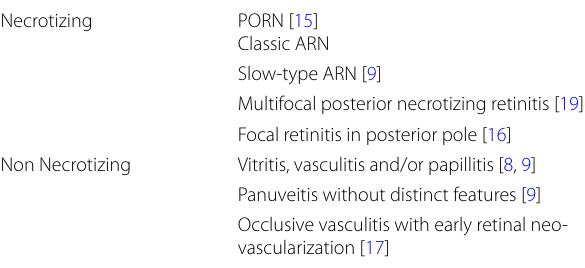
Table 1 The different forms documented in the literature for posterior herpetic uveitis in the immunocompetent